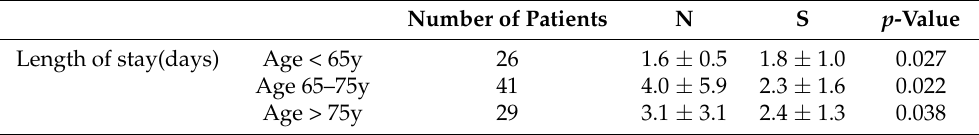
Table A1. The effect of age on length of hospital